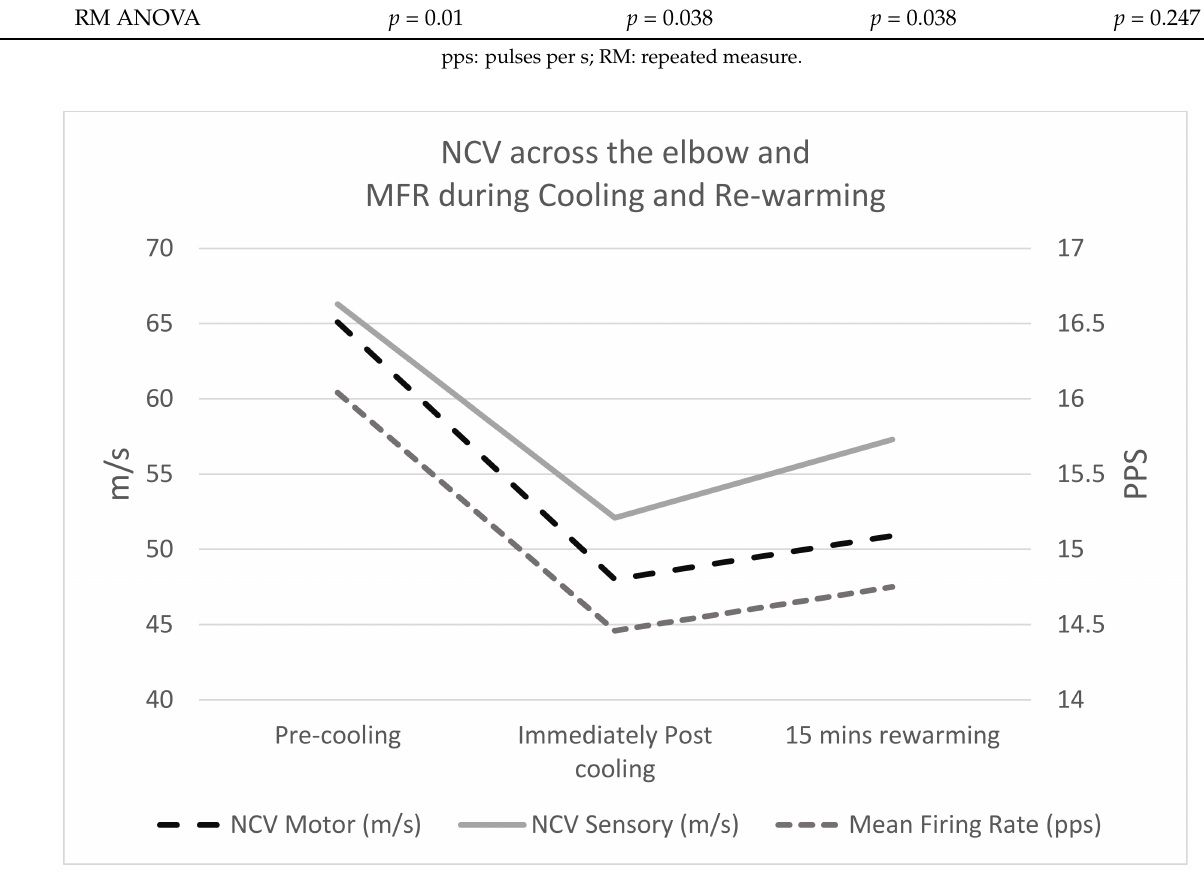
Figure 3. NCS and MFR during cooling and re-warming. Table 4. Post hoc pairwise